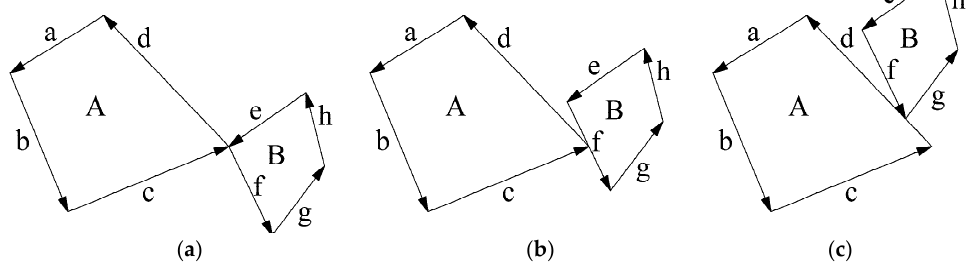
Figure 3. Three touching cases of two polygons. ( a ) First touching case; ( b ) Second touching case; ( c ) Third touching case.